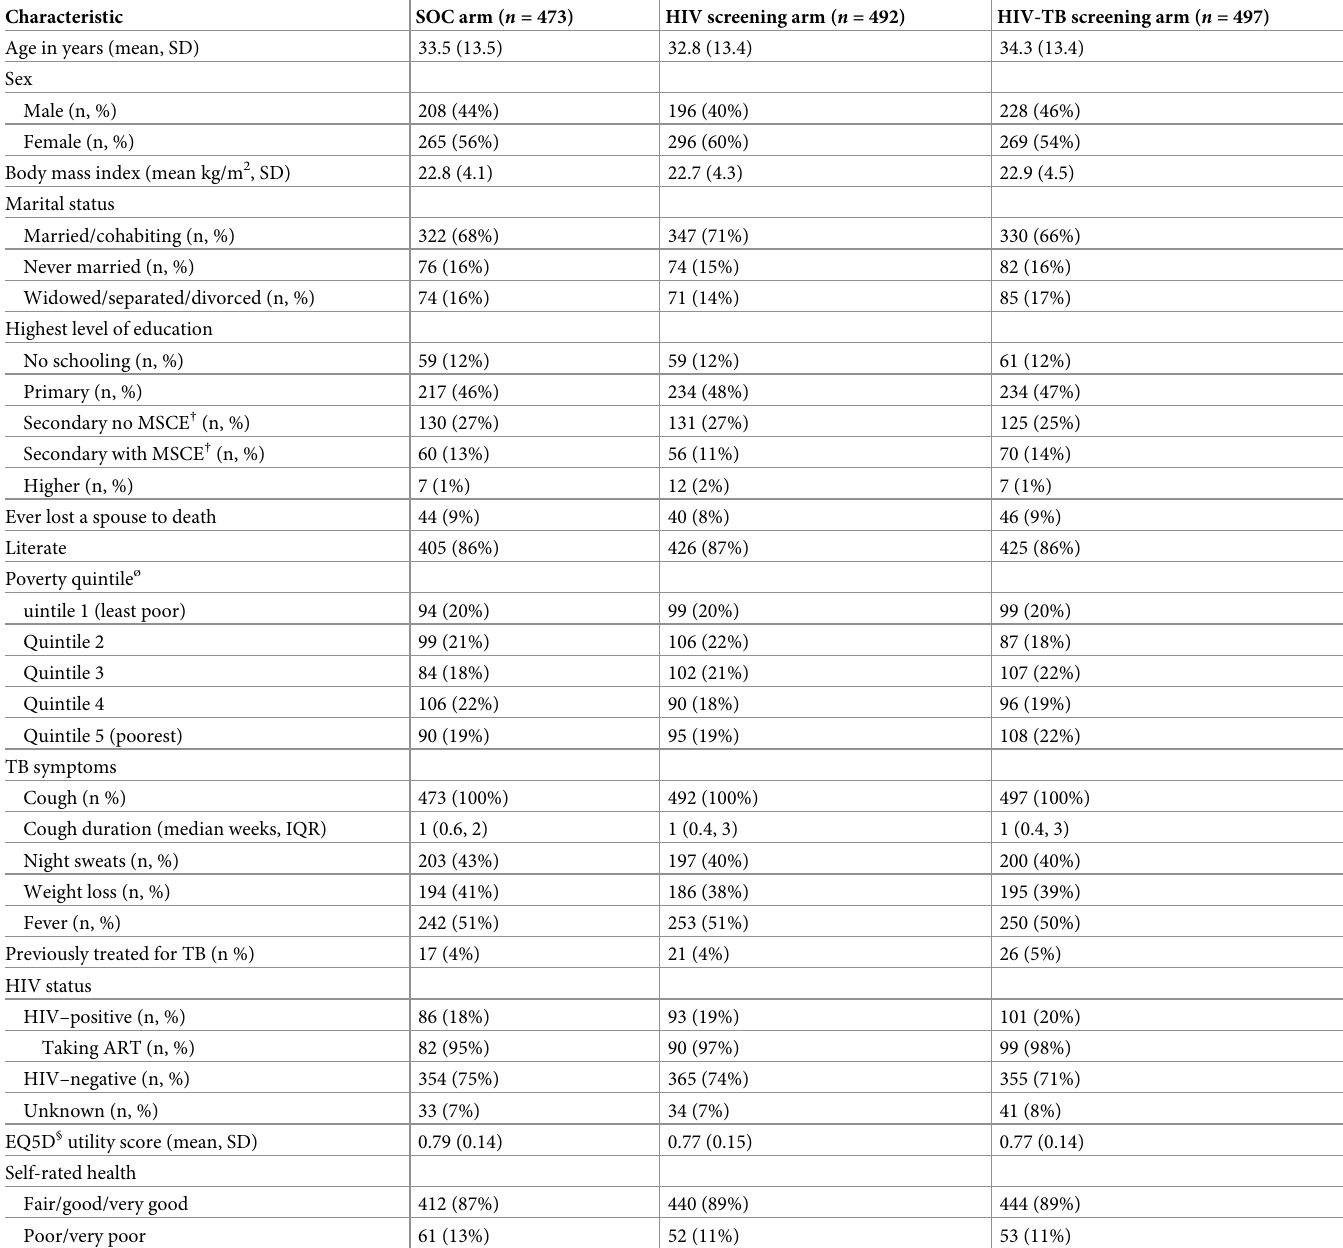
Table 1. Participant